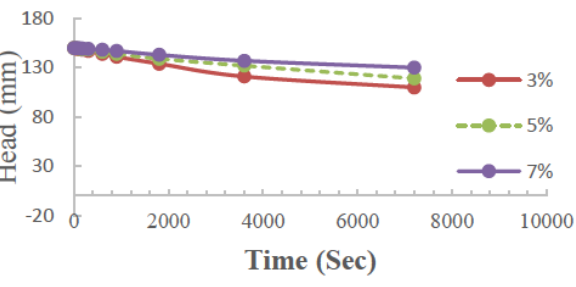
Figure 11: Comparison between (k*10 −5 ) coeflcients of permeability with 3%, 5%, and 7% stabiliser applied to the